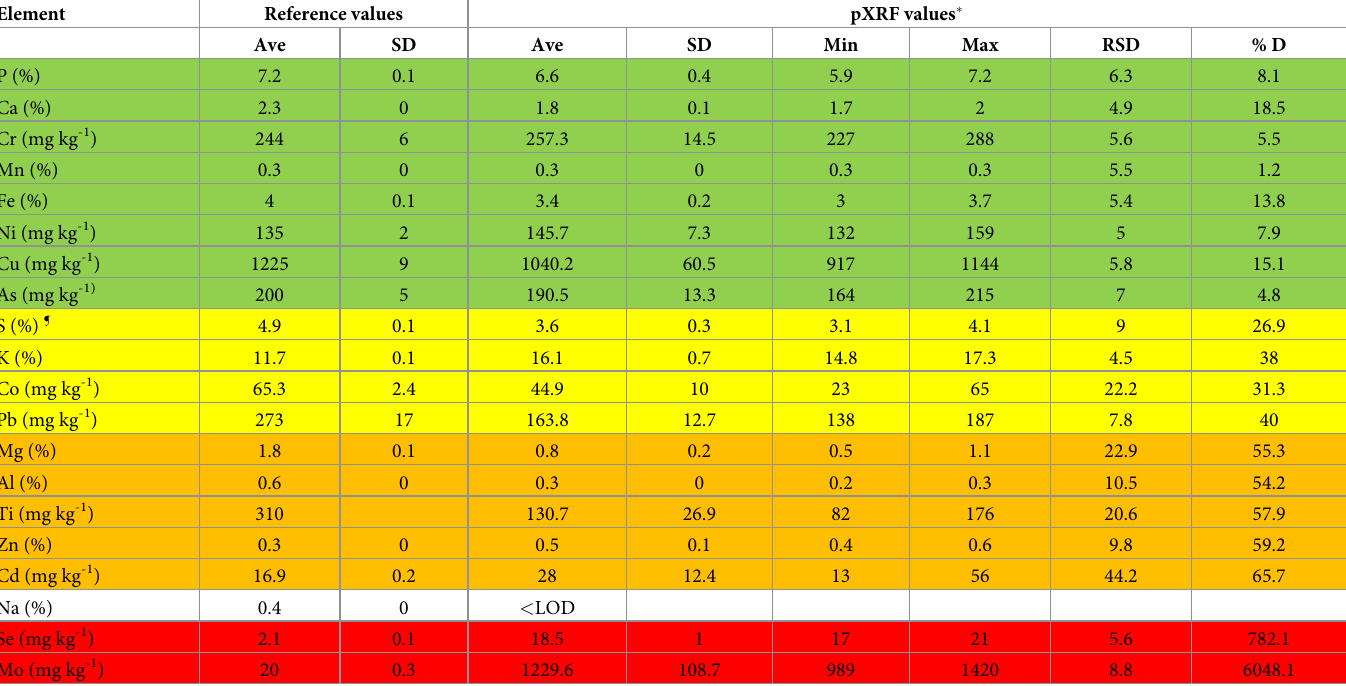
Table 9. Elemental composition of NIST SRM 695.